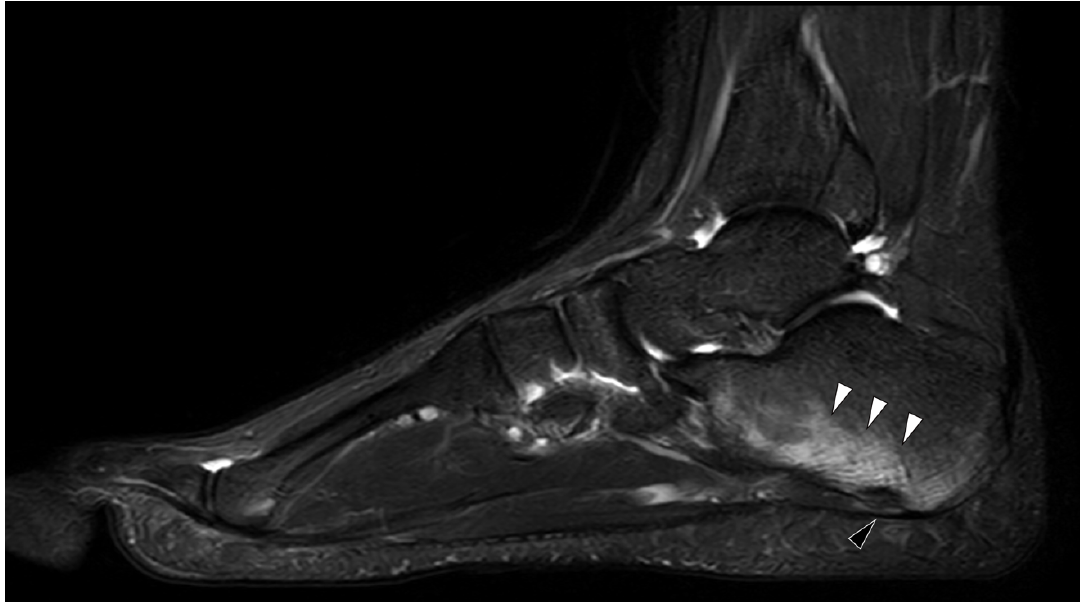
Figure 1. MRI in Familial Mediterranean fever (FMF). Sagittal T2 weighted with fat saturation image of an ankle of an 18 years old male with known FMF and exertional leg pain. There is characteristic enthesitis (black arrowhead) with extensive calcaneal bone marrow edema (white arrow heads) at the insertion of the long plantar tendon.